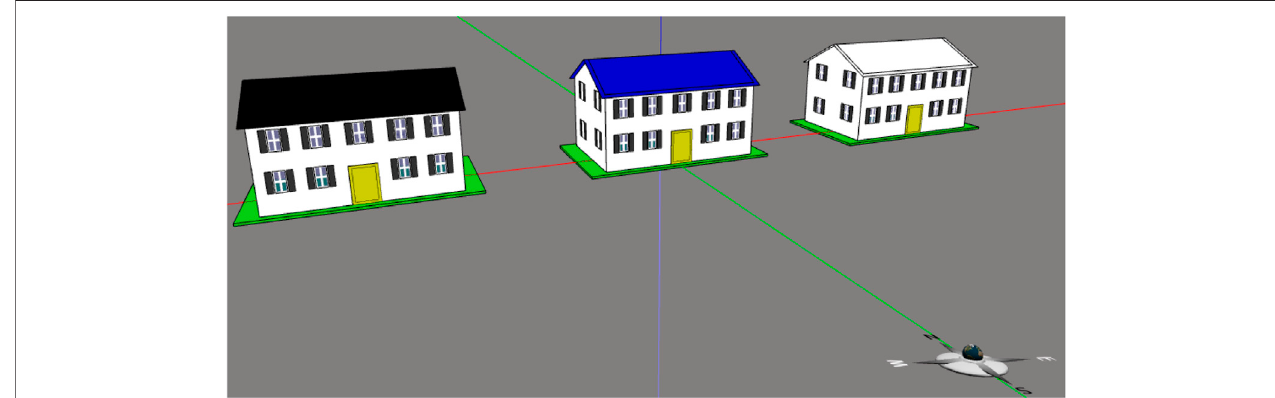
FIGURE 3 | Scheme of three geometrically identical houses with different exterior surface colors.